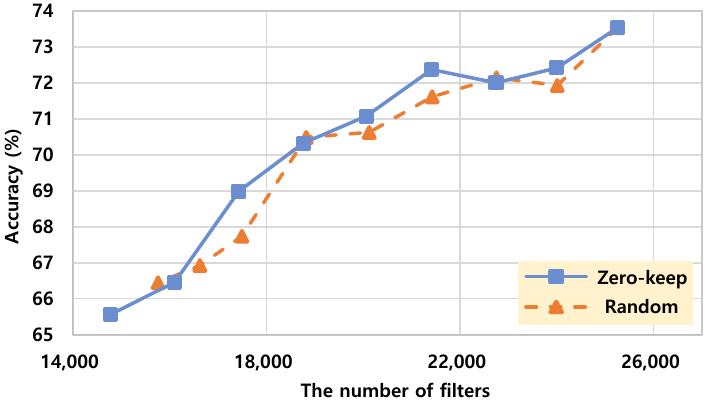
Figure 8. The number of filters versus accuracy trade-off comparison on Resnet-50.